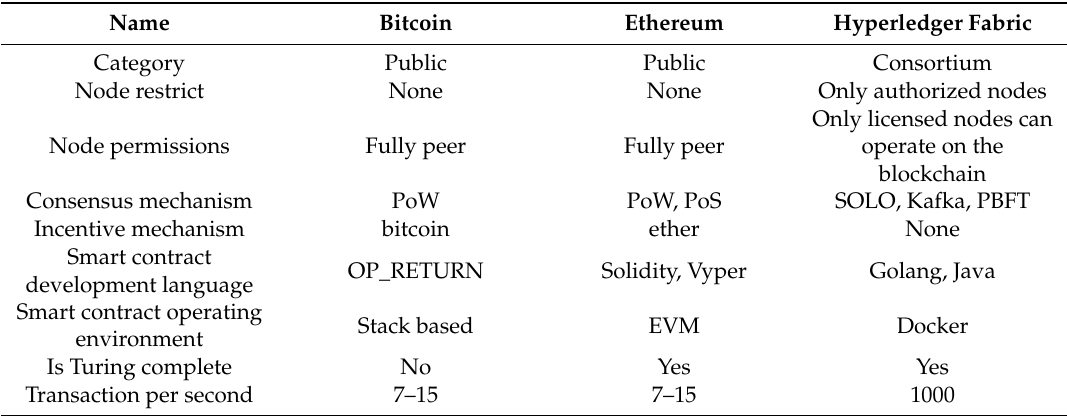
Table 1. Comparison of di ff erent blockchain